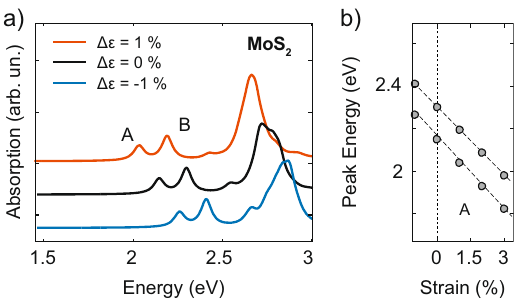
Fig. 3 Calculated BSE absorption spectra under biaxial strain of single-layer MoS 2 ( a ). An arti fi cial broadening of 0.035 eV is used in the BSE calculations and the spectra are vertically shifted for improved visibility. The energies of the A and B excitons are extracted from the ab-initio calculations ( b )